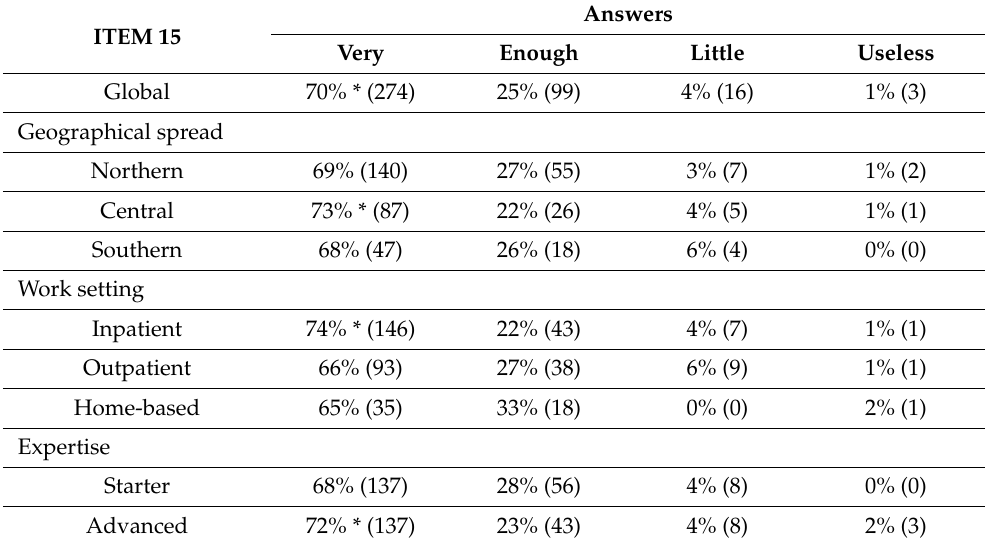
Table 6. Answers referred to item 15: How much do you think that an early mobilization program